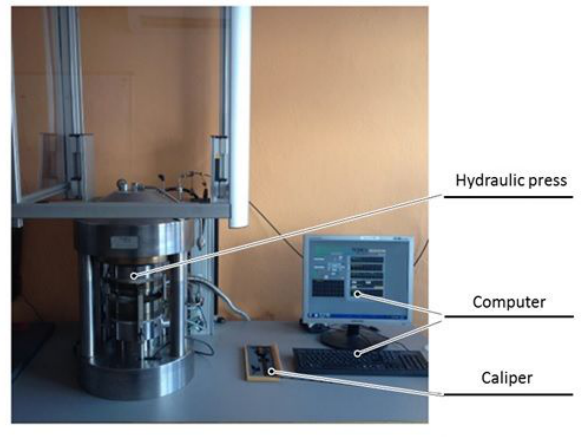
Figure 12: Test rig for the determination of the gasket’s elastic